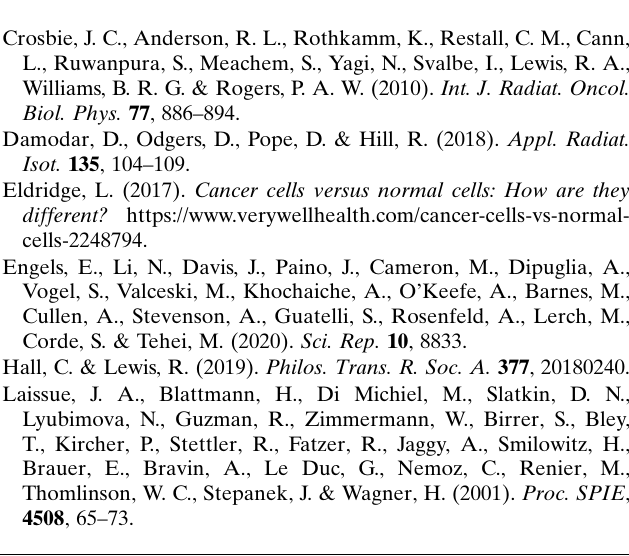
Figure 17 Phase-contrast 2D micrographs of HEM, MM418-C1, CCD841 and SW48. (A) HEM individual cell with average size/length of (cid:3) 500 m m, (B) MM418-C1 individual cells with average size/length of (cid:3) 100 m m, (C) CCD841 individual cell with average size/length of (cid:3) 500 m m and (D) SW48 individual cells with average size of (cid:3) 50 m